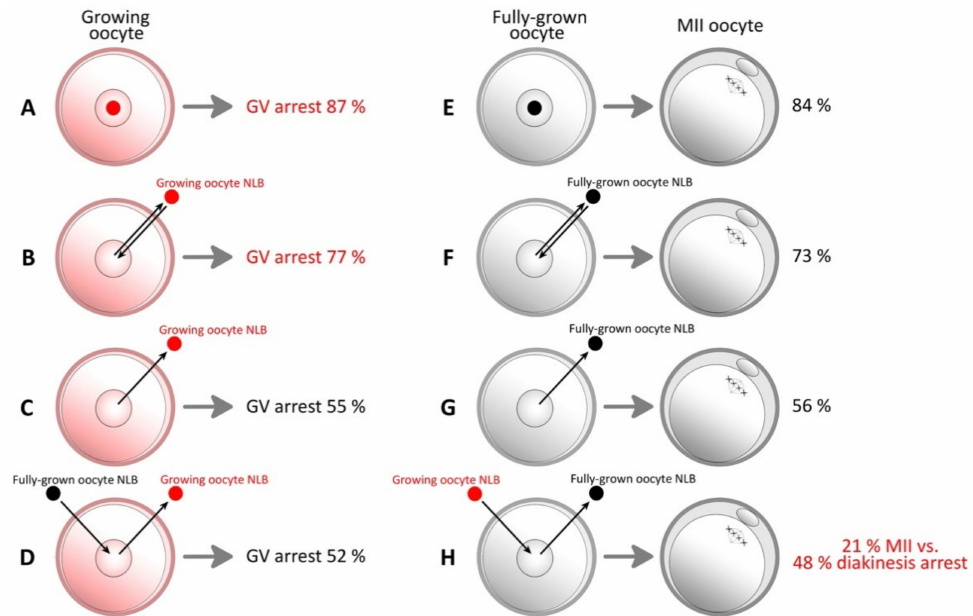
Figure 2. Enucleolation and re-injection of growing and fully grown oocytes. ( A , E ) Intact group. A growing oocyte has limited meiotic competence during the in vitro maturation, and its maturation fails. On the other hand, a fully grown oocyte matures to the metaphase II (MII) stage without any problems; ( B , F ) enucleolation and re-injection back into oocytes does not have a significant effect on maturation rate compared to the control group; ( C , G ) NLB removal from a growing oocyte has a significant impact on maturation rate. Along with that, the inhibitory effect is also eliminated. Results in fully grown oocytes correspond with previous observations [13]; ( D , H ) when the growing oocyte NLB is replaced with an NLB from a fully grown oocyte, the results were very similar to enucleolated growing oocytes. Surprisingly, when a fully grown NLB is replaced with an NLB from a growing oocyte, the maturation rate drops, and 48% of oocytes were arrested in diakinesis. This supports the idea that the NLB from growing oocytes has an inhibitory effect on oocyte maturation